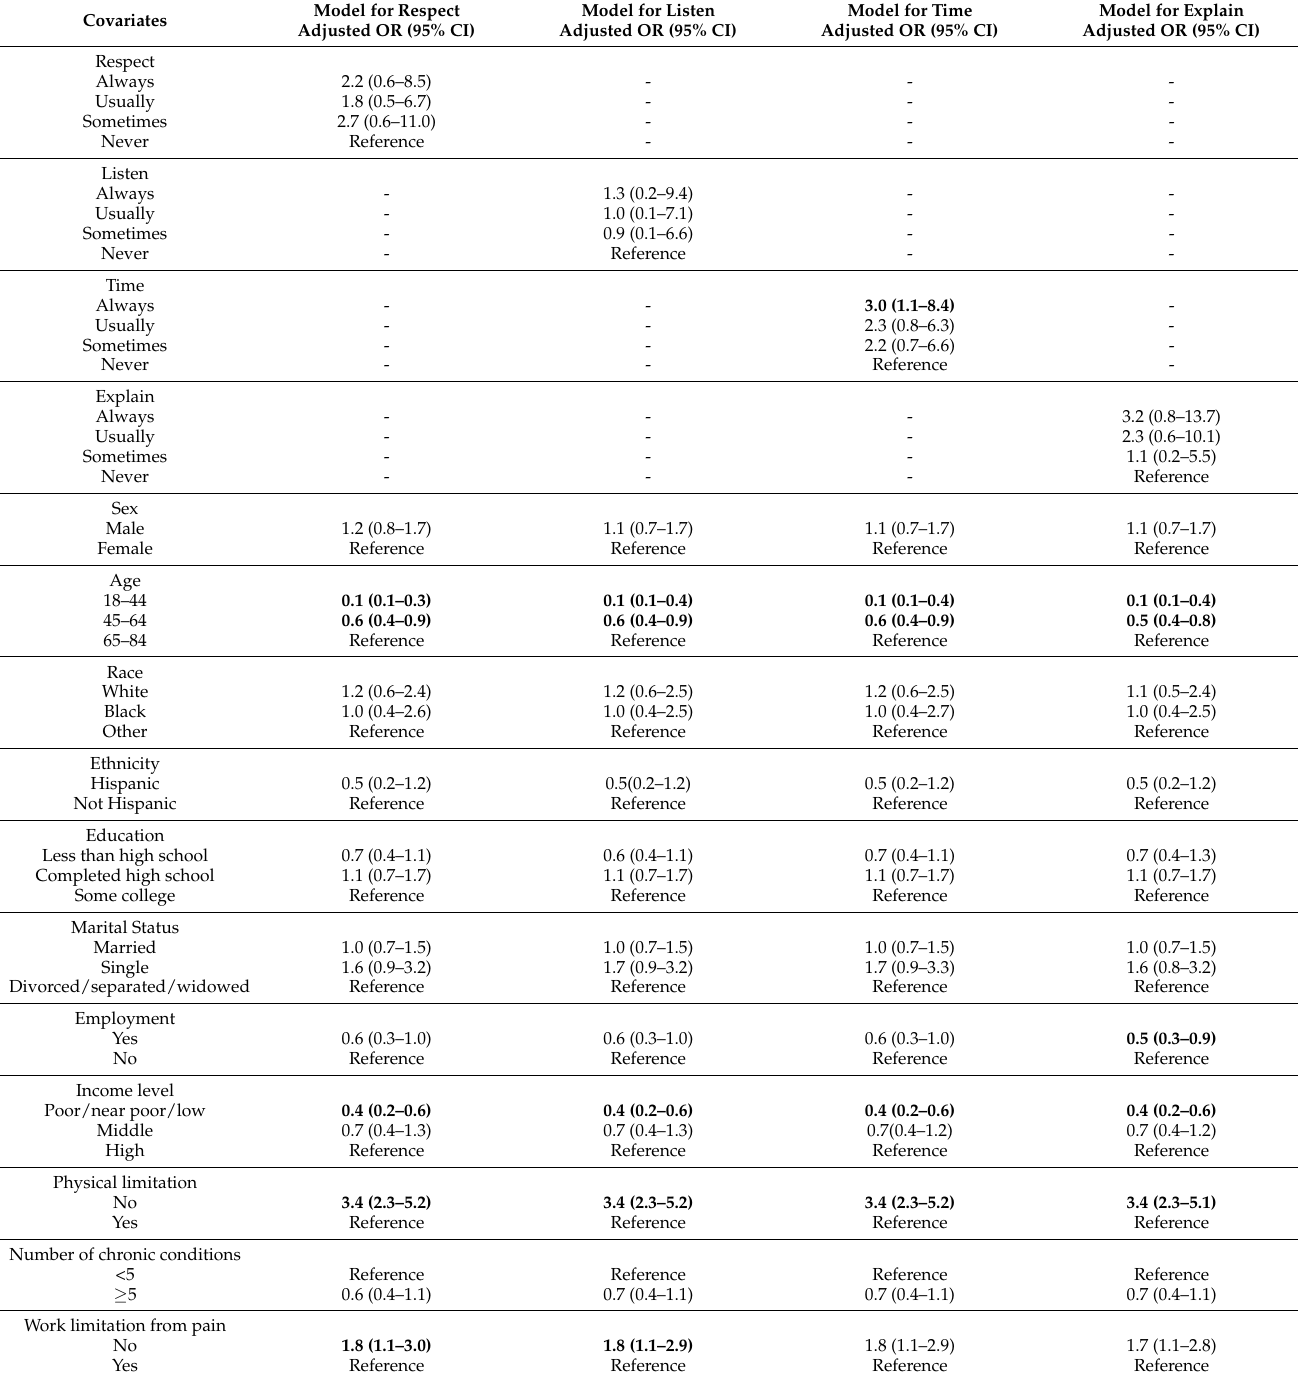
Table 3. Adjusted odds ratios from the binary logistic regression for the four models (respect, listen, time, and explain) to assess the association between patient–physician communication and good mental health